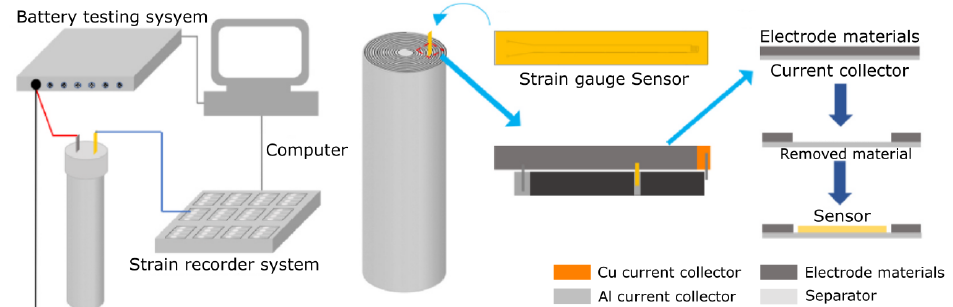
Figure 7. Integration of thin film strain gauge sensor in current collector of the positive electrode of the cell jelly roll. Reprinted with permission from ref. [42]. Copyright 2022 Elsevier